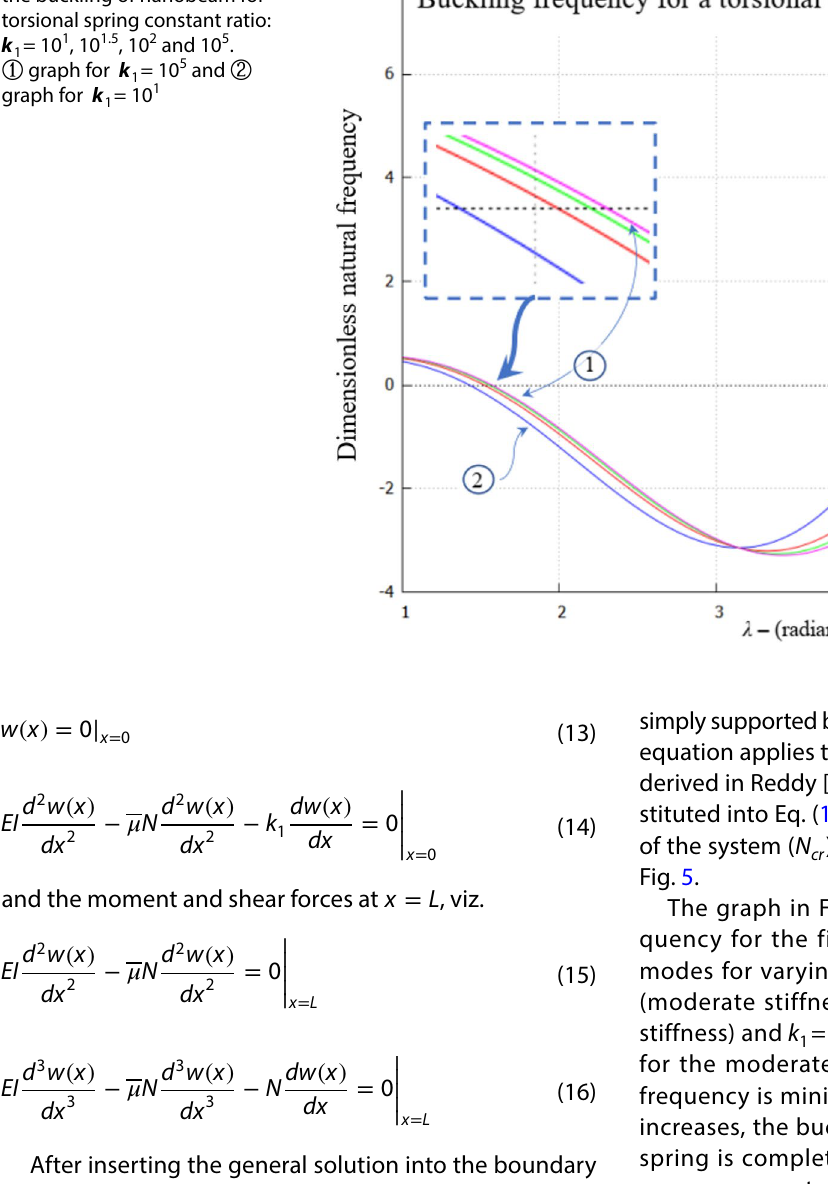
Fig. 5 Characteristic graph for the buckling of nanobeam for torsional spring constant ratio: